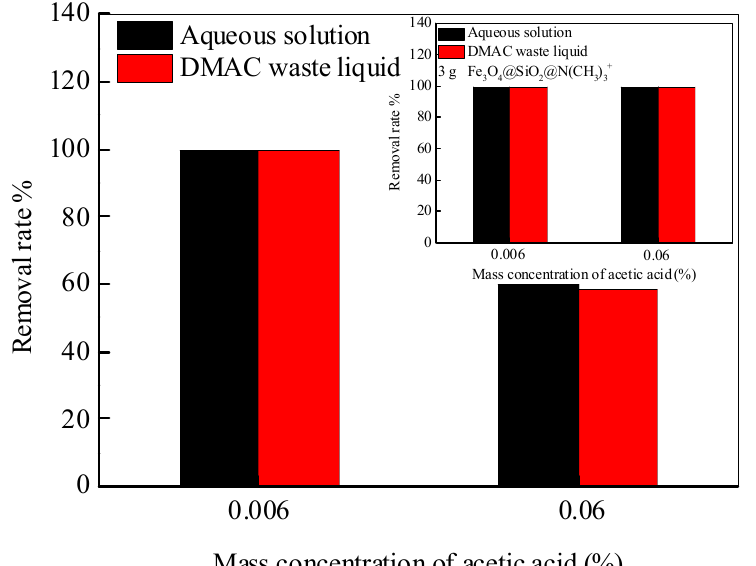
Figure 6. The removal rate of acetic acid in water and DMAC waste liquid by Fe 3 O 4 @SiO 2 @N(CH 3 ) 3+ .